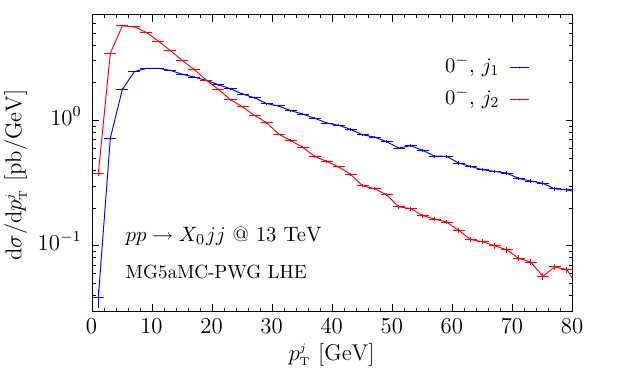
cos α = 0, namely, the pseudoscalar case. On the right panel in red, the inclusive rapidity of the X 0 boson, for the same CP scenario as in the left panel. Both plots are obtained with